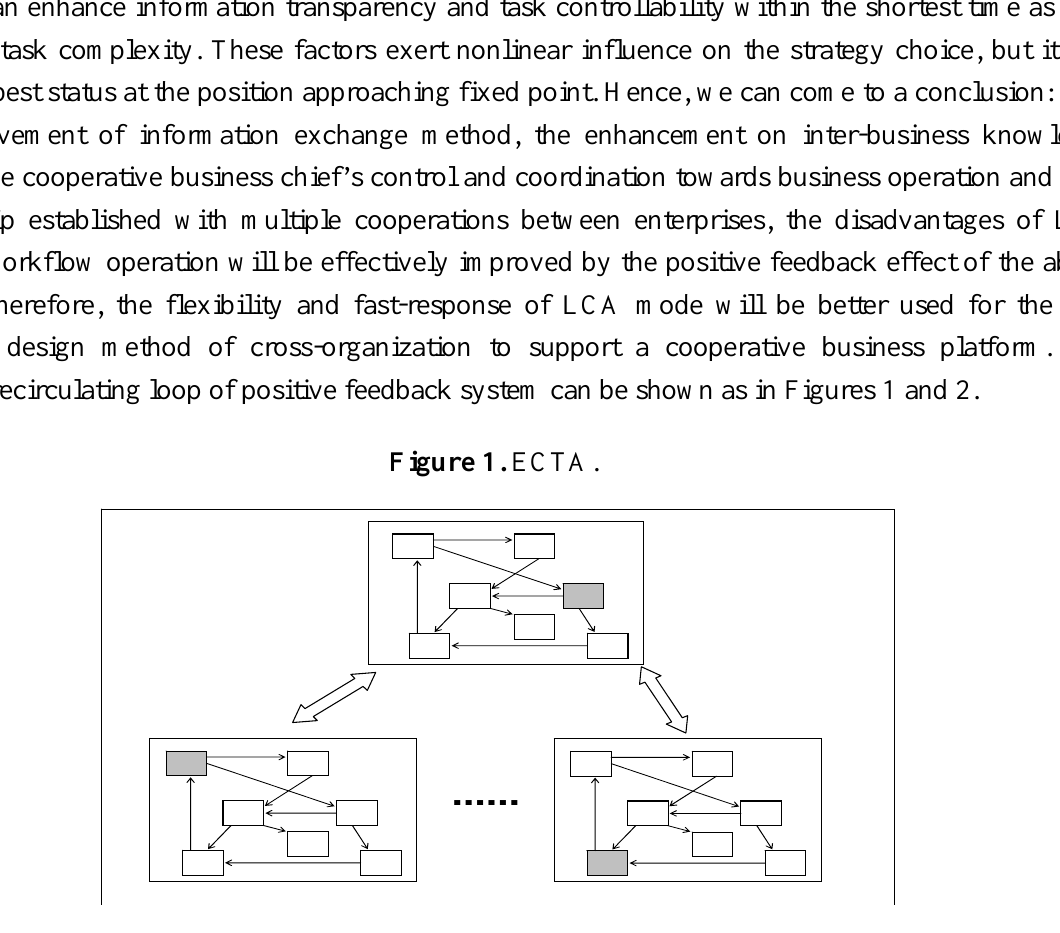
Figure 2. Illustration of positive coordinative system of LCA mode.